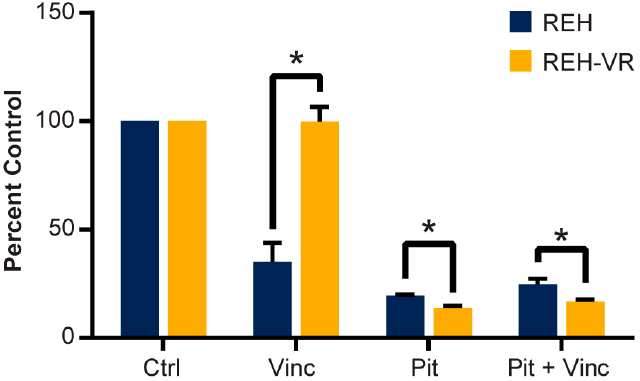
Figure 7. Combination treatment with pitavastatin and vincristine. REH and REH-VR cells were treated with either vehicle or pitavastatin (Pit, 450 nM) for 24 h, after which indicated cells were treated with either vincristine (Vinc, 2 nM), for an additional 48 h or total treatment time of 72 h and proliferation was determined with a CCK-8 (WST-8) assay. Pitavastatin did not show augmen- tation of vincristine activity. Each bar represents average ± S.D., where n = 3; * p < 0.05 denotes statistical